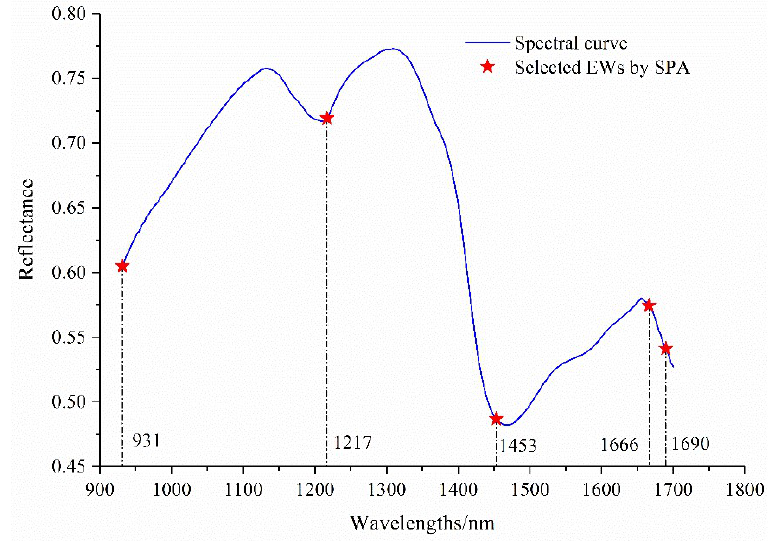
Figure 7. The distribution of the obtained effective wavelengths (EWs) selected by the successive projections algorithm